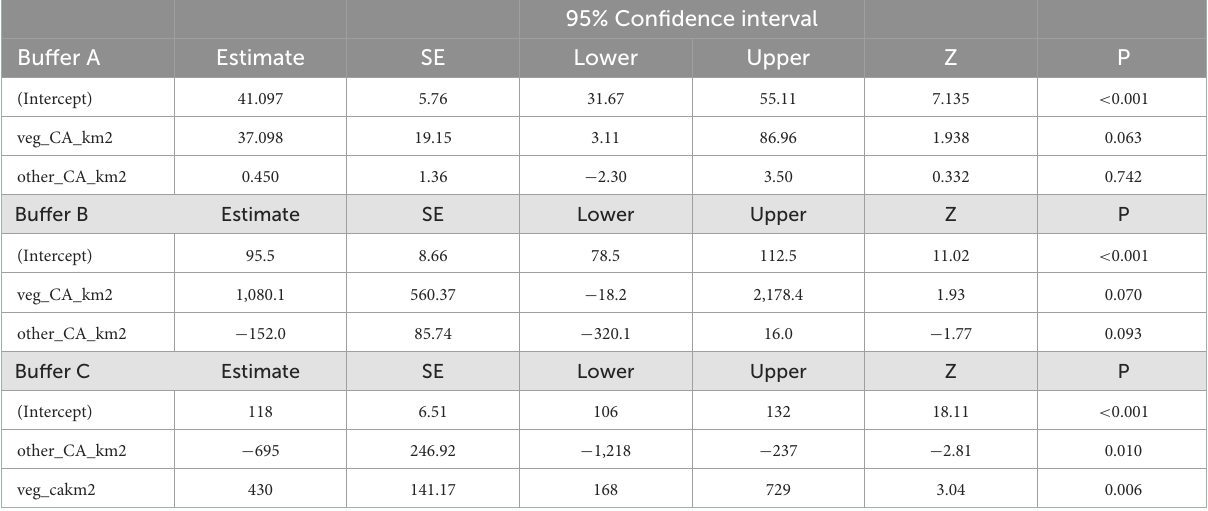
95% Confidence interval